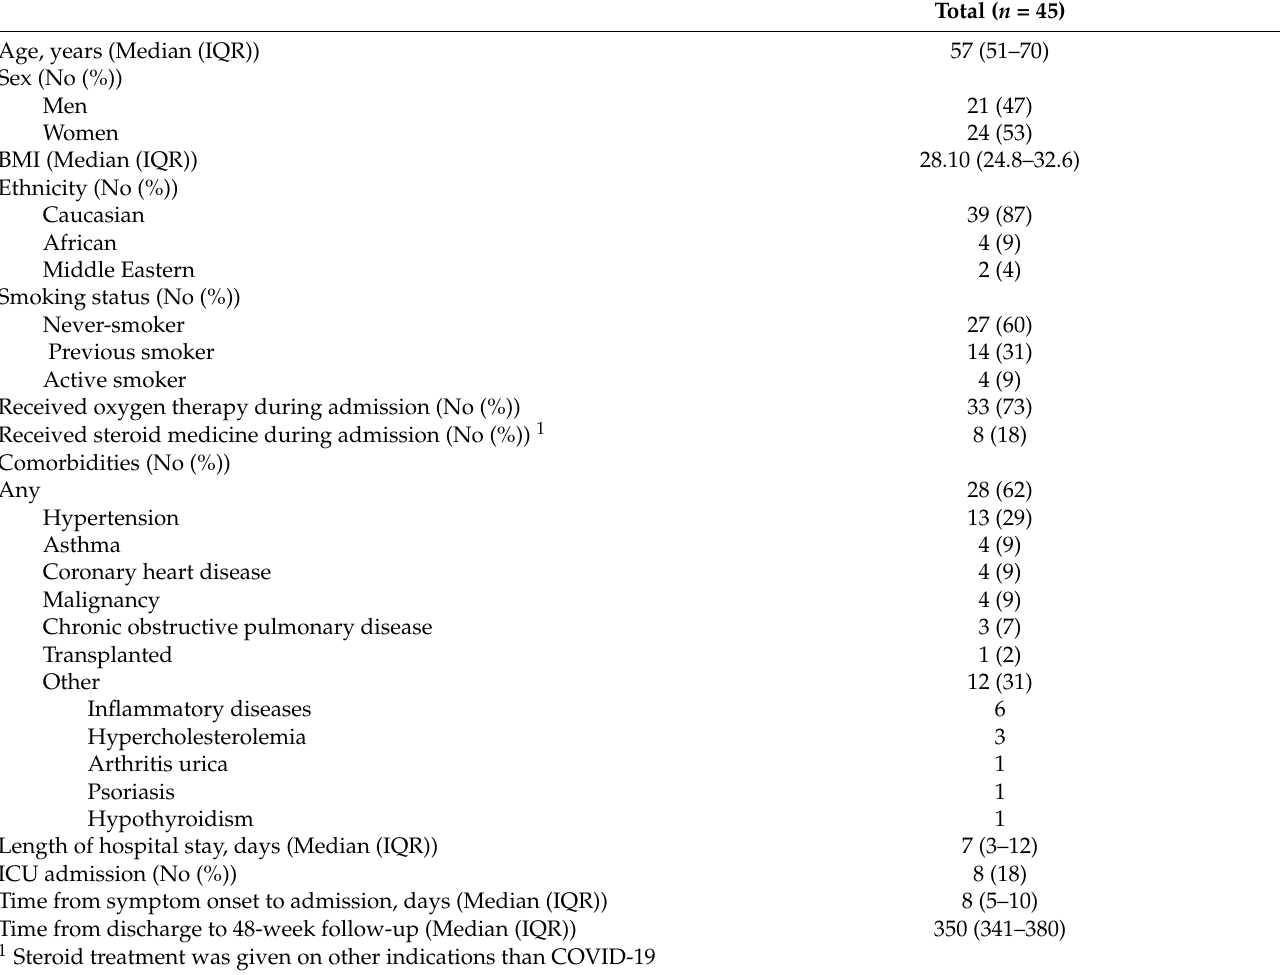
Table A1. Characteristics of the enrolled patients.